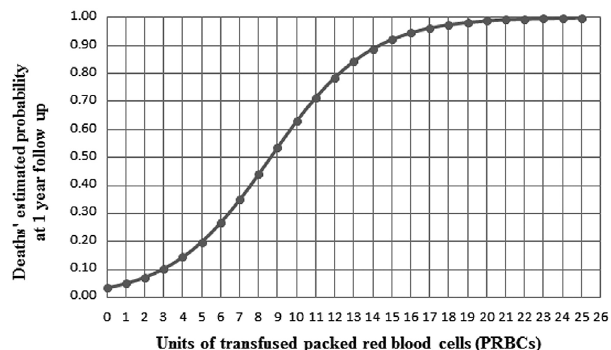
Fig. 3 - Estimated probability of death at 1 year of follow up with the number of units of